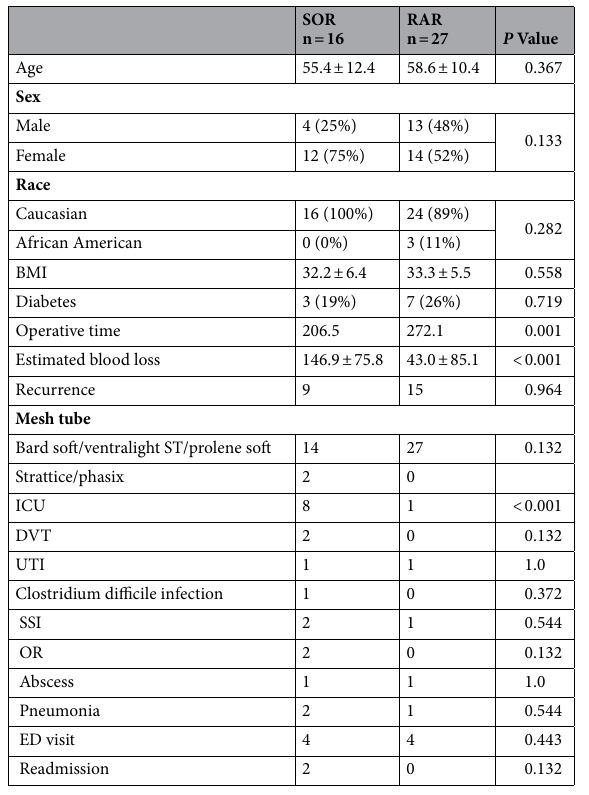
Table 1. Demographics and complications comparison. SOR standard open repair, RAR robotic assisted repair, BMI body mass index, DVT deep vein thrombosis, UTI urinary tract infection, SSI surgical site